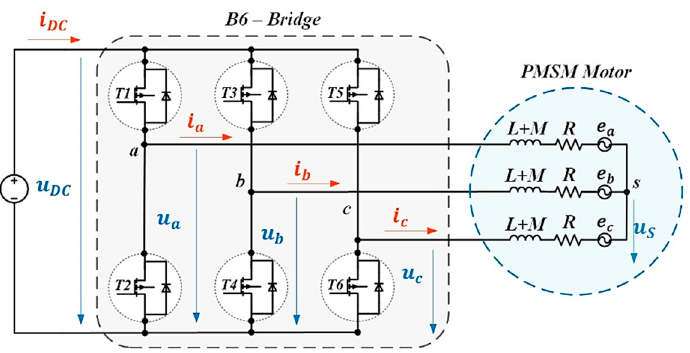
Figure 1. B6-bridge-fed 3-phase permanent magnet (PM) drive connections.